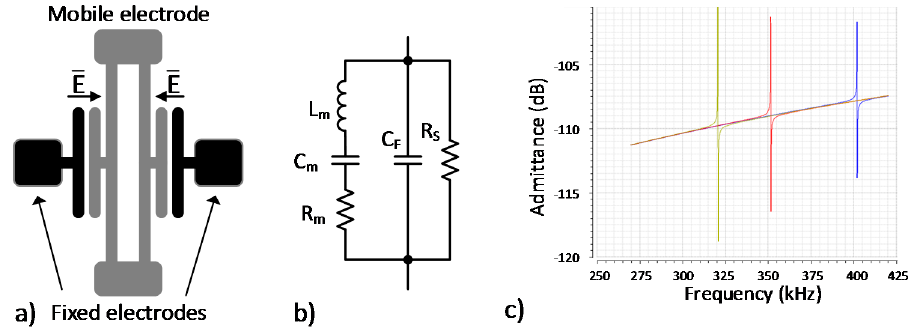
Figure 1. ( a ) Standard layout for a DETF. ( b ) Equivalent electro-mechanical model of DETF with parasitic elements. ( c ) Typical admittance spectra of DETF without applied strain (red line) and with positive (yellow) or negative (blue) applied